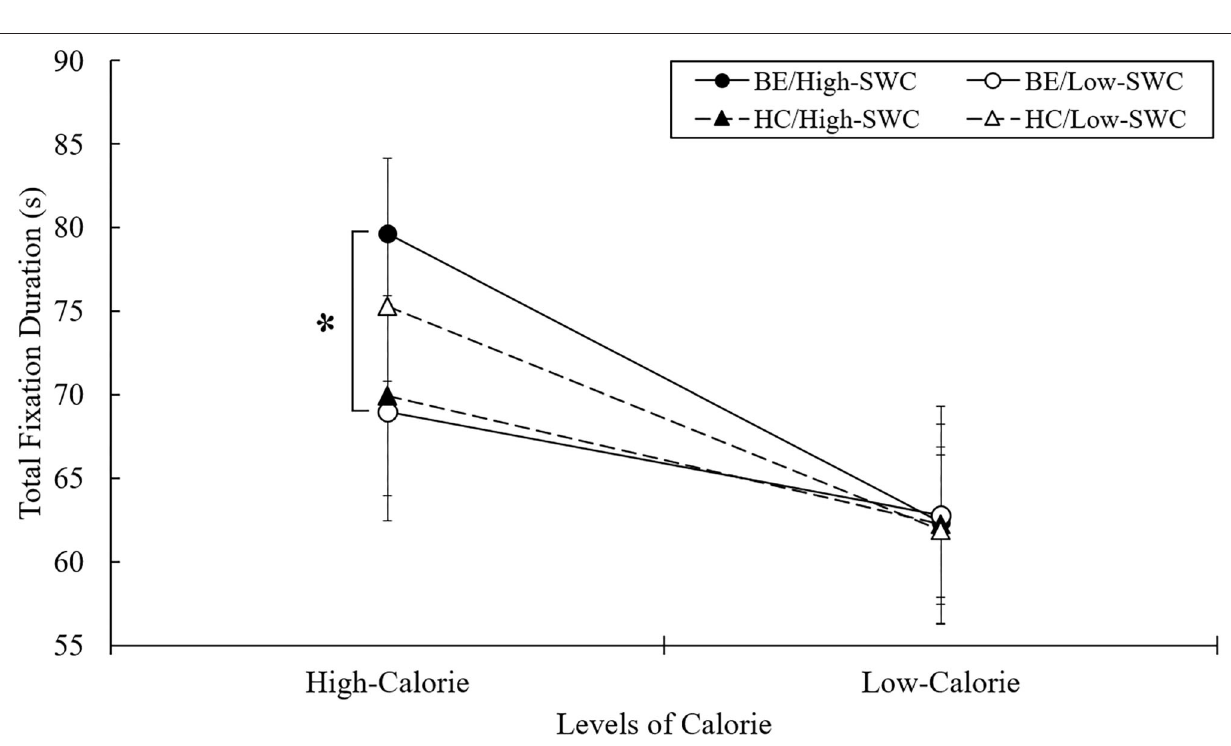
Frontiers in Psychiatry |